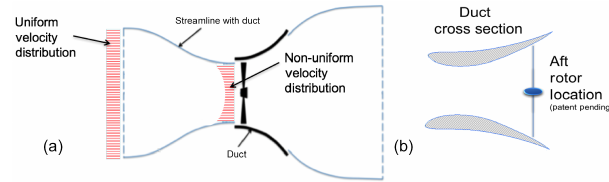
Figure 3. Key design aspects for the Clarkson ducted turbine. (a) Non-uniform velocity distribution. (b) Aft rotor location.